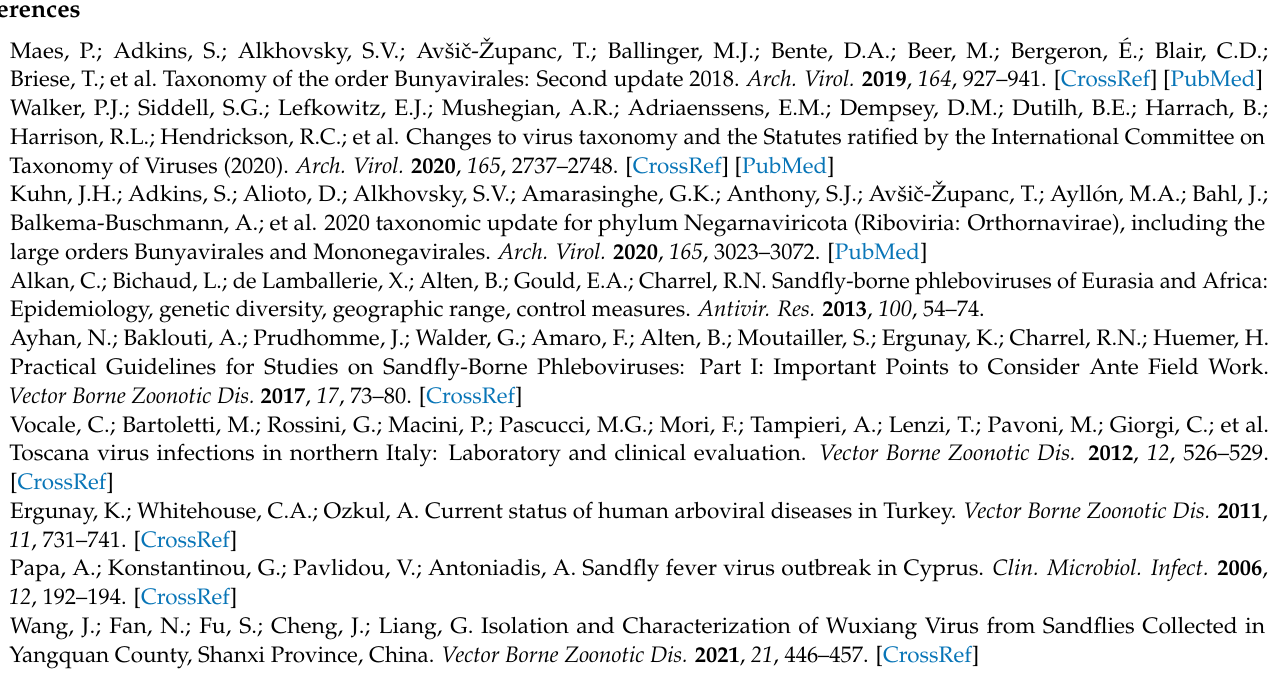
Supplementary Table S2: Information on the virus strains analyzed in this study, Supplementary Table S3: Nucleotide and amino acid homologies of the M segment of sandfly viruses isolated in Yangquan County, Supplementary Table S4: The homology analysis of nucleotide (amino acid) sequence of NS gene of WUXV viruses isolated in Yangquan County, Supplementary Table S5: The homology analysis of nucleotide (amino acid) sequence of N gene of WUXV viruses isolated in Yangquan